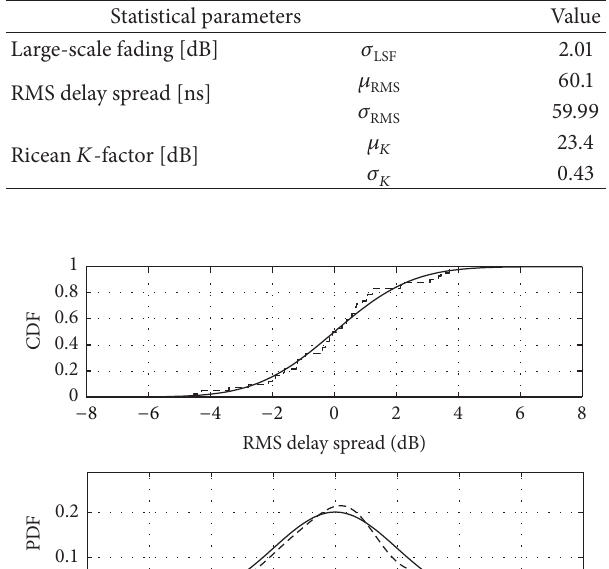
Table 3: Distribution parameters.